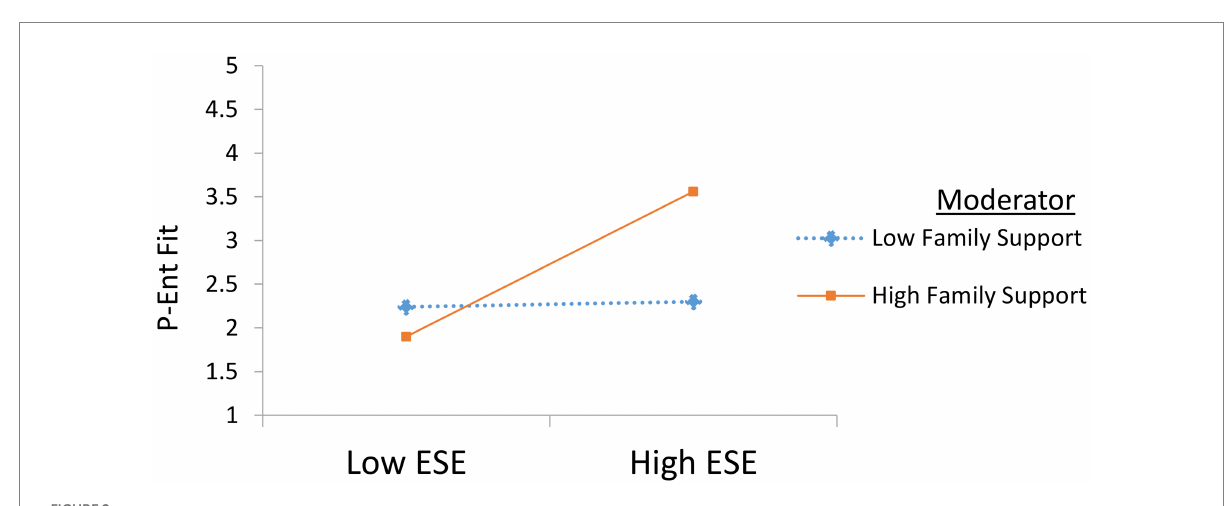
FIGURE 2 Slope of moderated